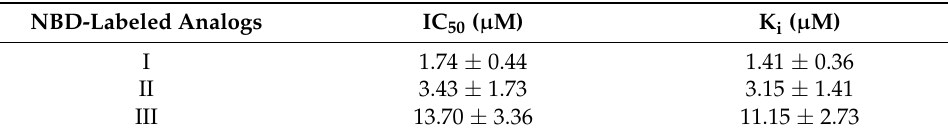
Table 1. IC 50 and K i values of fluorescent NBD-labeled serotonin analogs for binding to serotonin 1A receptors stably expressed in CHO-K1 cells a .